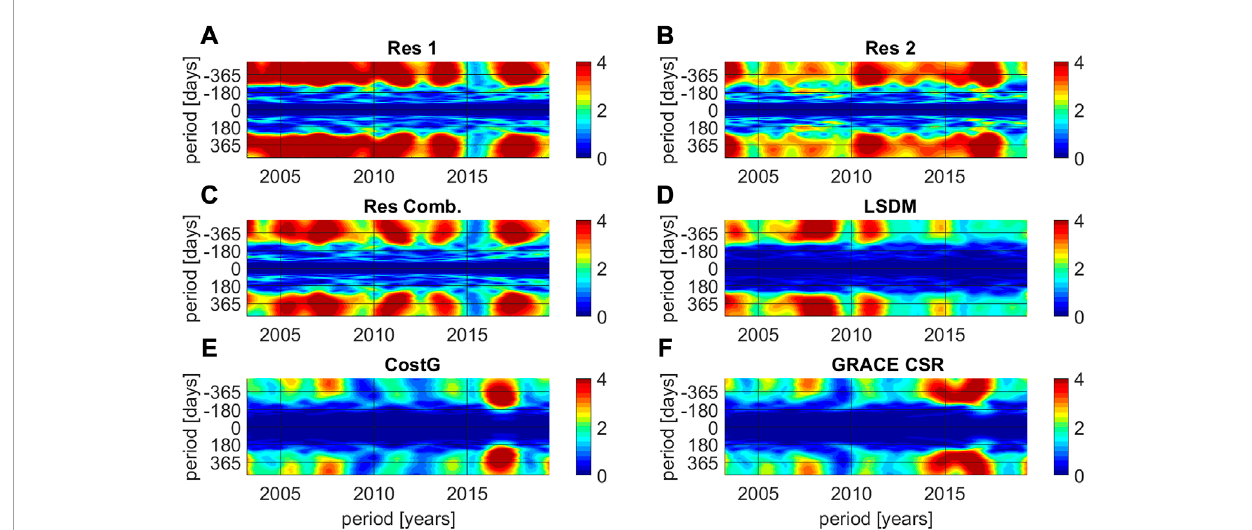
FIGURE 8 The time variable spectrum of the 60–500 days band of the geodetic residual excitations Res1 (A) , Res2 (B) , Res Comb. (C) , HAM LSDM hydrological model (D) , gravimetric-based excitation determined from a combined GRACE/GRACE-FO solution (COST-G) (E) , and single GRACE/GRACE-FO solution (CSR) (F) (in mas).